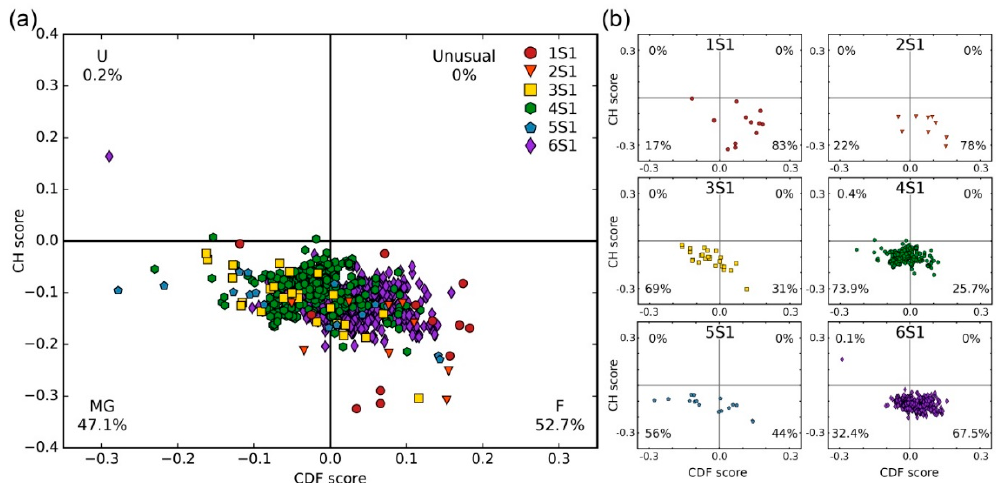
Figure 1. ( a ) Binary disorder analysis (charge–hydrophobicity plot cumulative distribution function (CH-CDF) plots [22]) of 1374 S1 proteins; ( b ) separate S1 proteins groups containing different numbers of structural domains.